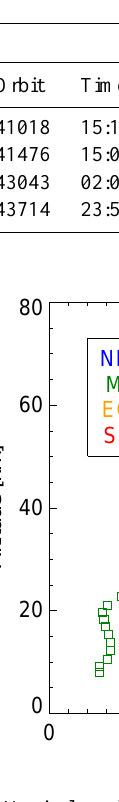
Table 6. Near-coincident ACE-FTS and MIPAS measurements.